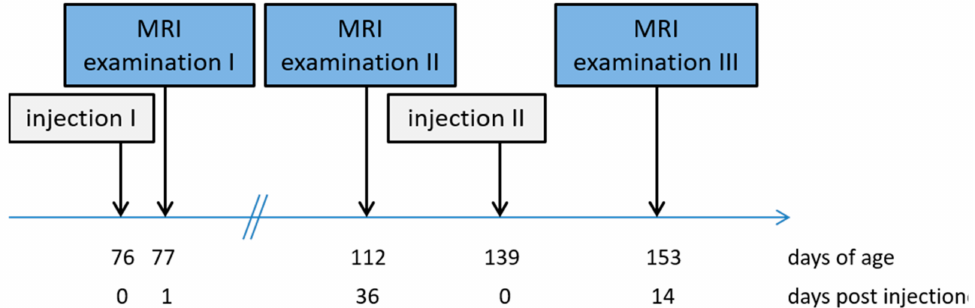
Figure 1. Sequence of the examination